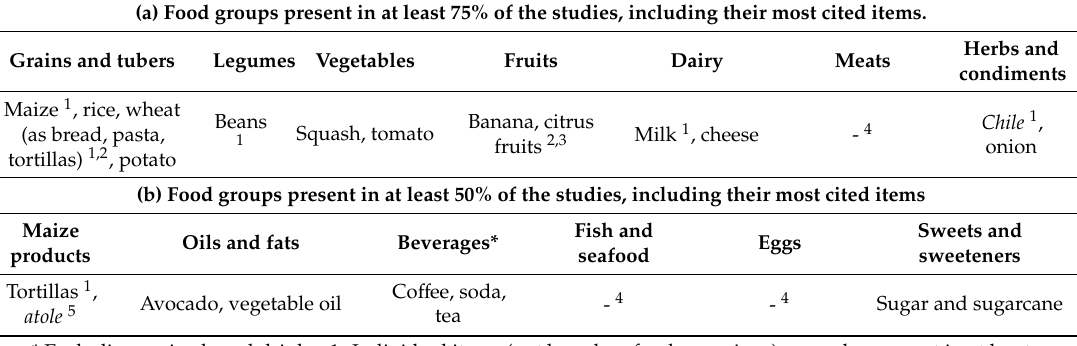
Table 4. Most cited items and food groups present in original studies. ( n =